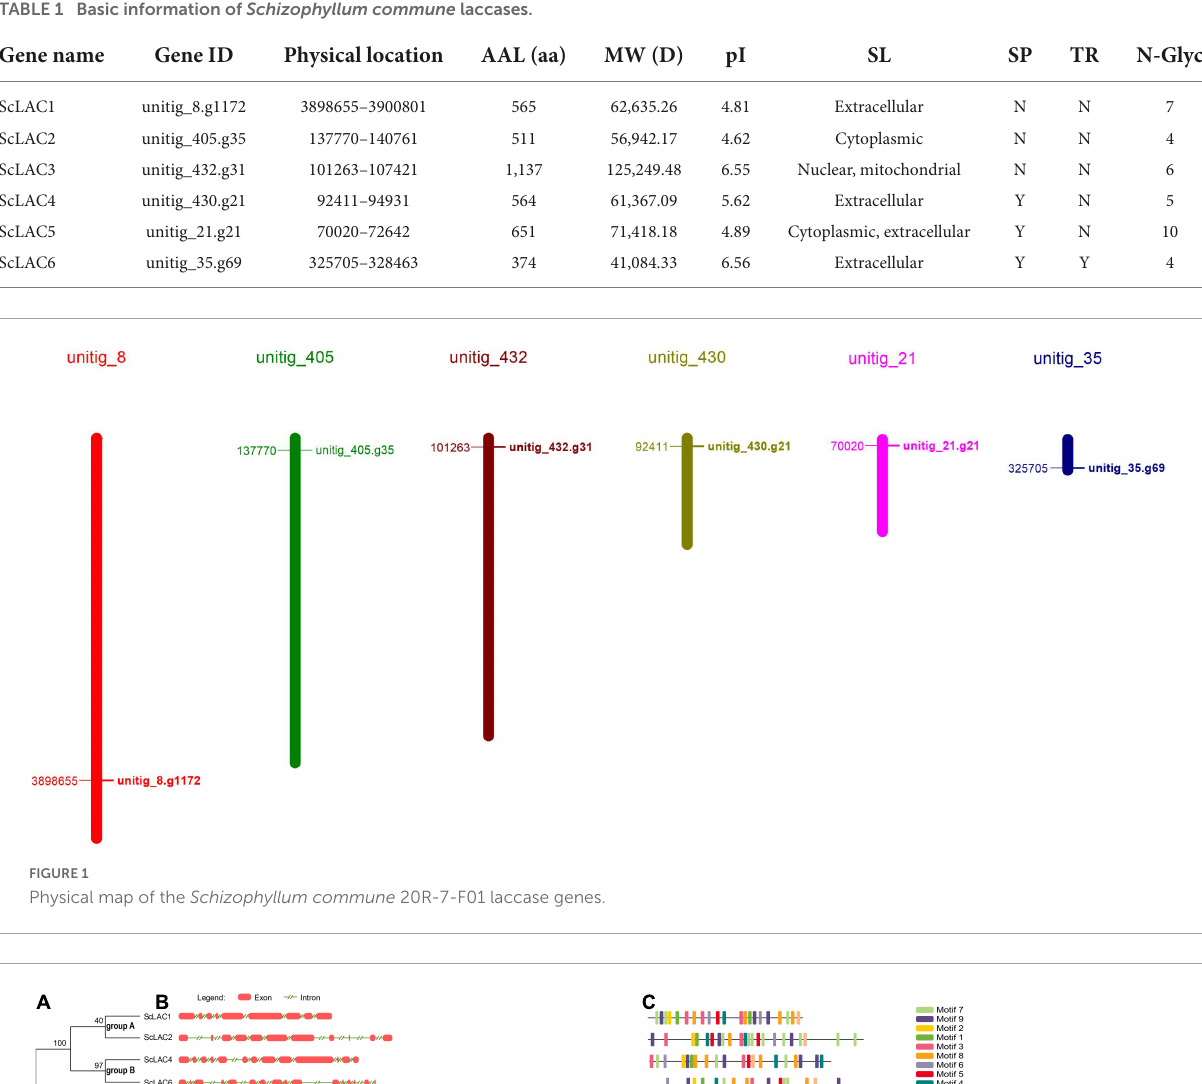
TABLE 1 Basic information of Schizophyllum commune laccases.